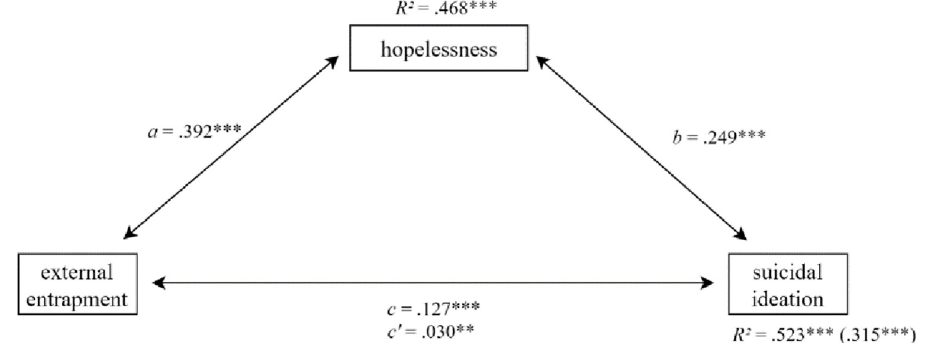
Fig 2. Mediation model 2 with external entrapment as predictor.